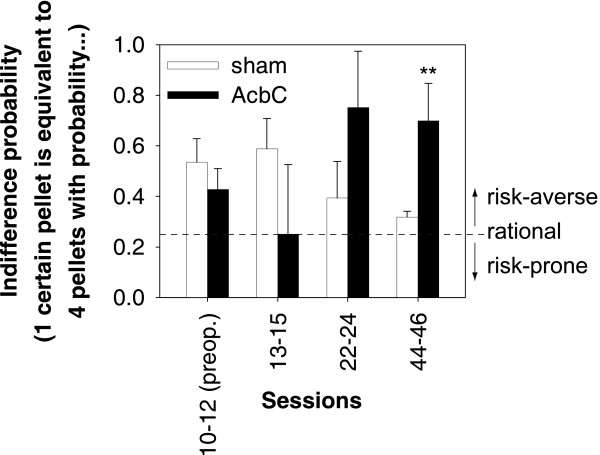
Indifference probabilities. Subjects' behaviour was analysed using a linear regression technique (see text for method of calculation) to estimate the large-reinforcer probability at which they were indifferent between a 4-pellet uncertain large reinforcer and a 1-pellet certain small reinforcer. Rational choice, and optimal choice in this task, would be an indifference probability of 0.25 (that is, it is rational to be indifferent between a certain 1-pellet reinforcer and a 4-pellet reinforcer delivered with a probability of 0.25), shown by the dotted line. Lower indifference probabilities imply risk-prone behaviour; higher indifference probabilities imply risk-averse behaviour. Preoperative and successive postoperative indifference probabilities are shown for AcbC-lesioned and sham-operated control rats (** p < .01, difference from controls).